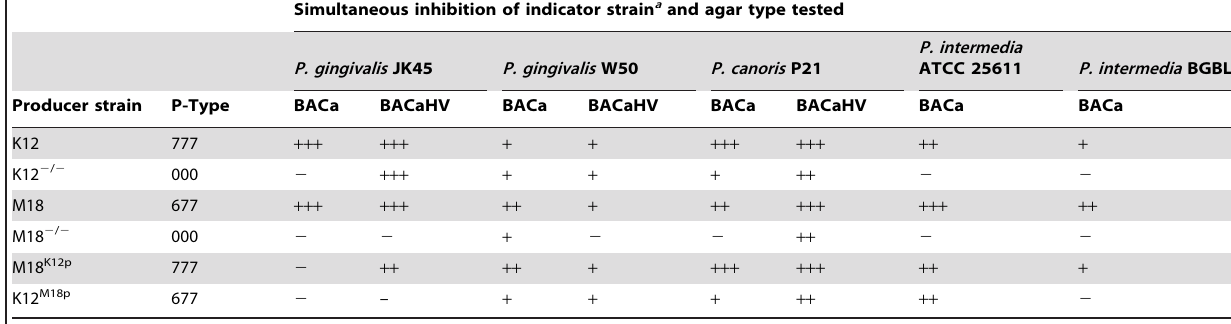
Table 1. Simultaneous antagonism of S. salivarius wild type and modified strains against selected oral bacteria.